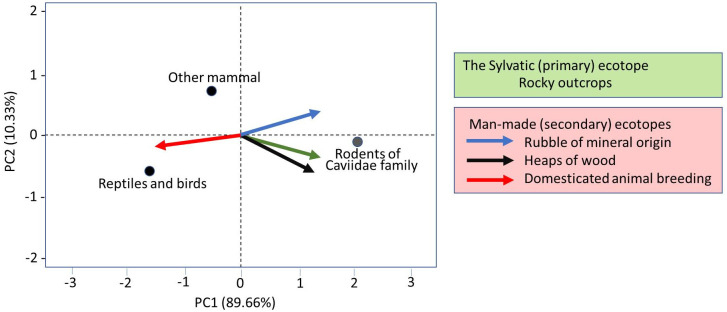
The main Triatoma brasiliensis food sources detected in each group of ecotope: The natural (rocky outcrops) and the artificial (mineral piles, woodpiles and livestock breeding) colonized by T. brasiliensis in the Rio Grande do Norte (RN) and Paraíba (PB) states analyzed by principal component analysis.